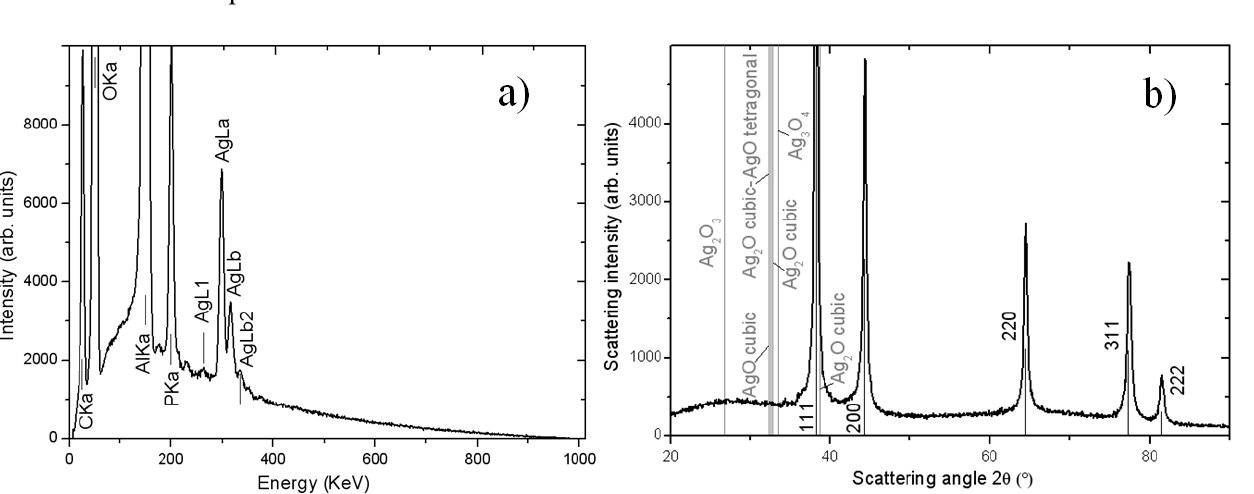
Figure 2. ( a ) Energy-dispersive X-ray microanalysis (EDS) spectrum of one APA substrate Ag-loaded with the chemical method; ( b ) X-ray diffraction (XRD) spectrum for the same